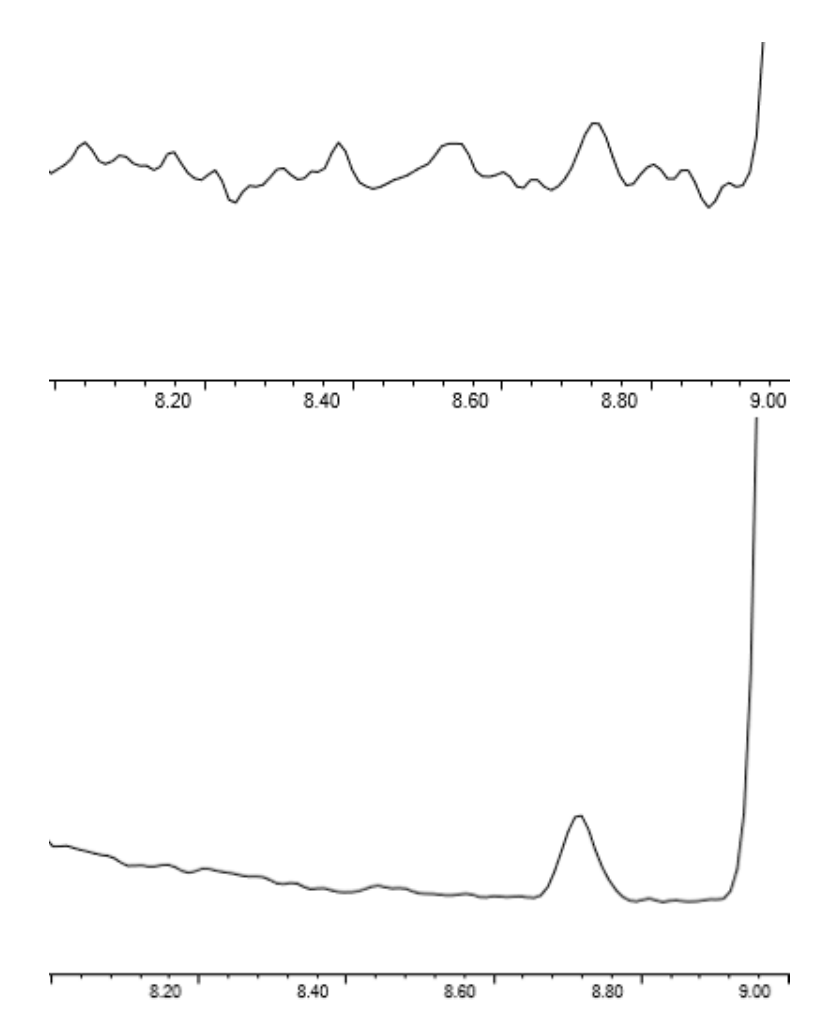
Figure 4. Scan ( top ) vs. SIM ( bottom ) acquisition for EtO at 34 ppt v.